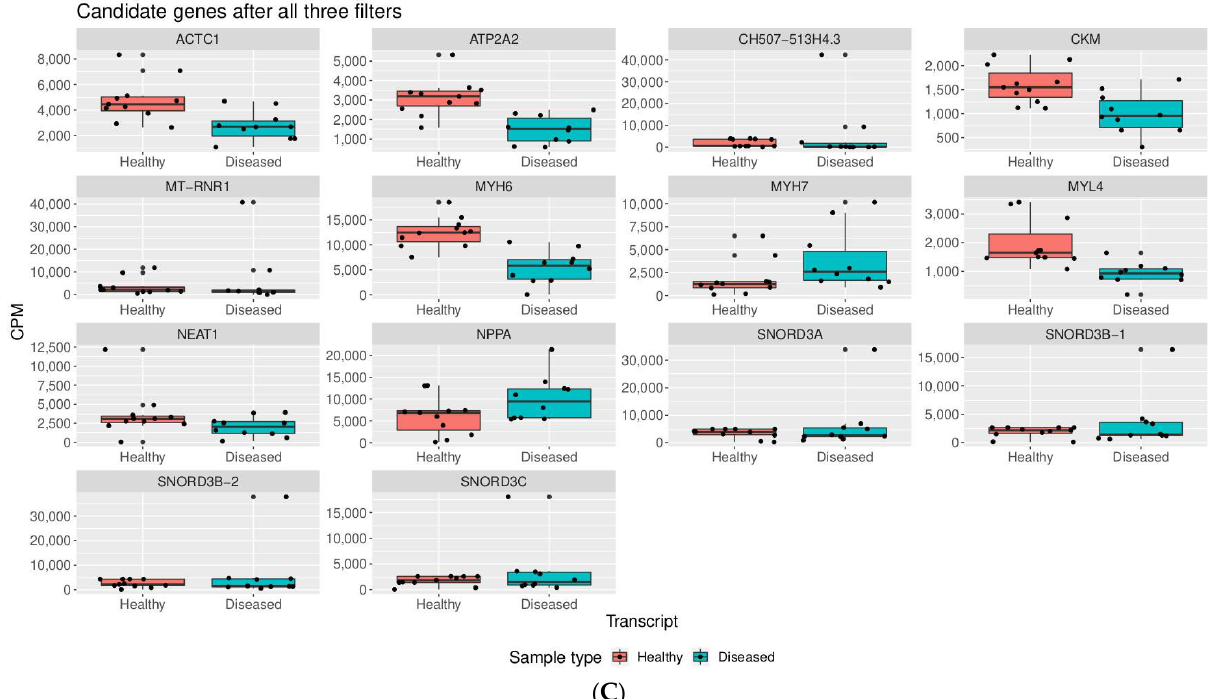
Figure 3. ( A ) Gene frequency of appearance after first selection. ( B ) Barplot reporting the number of retained genes after multiple feature selection step for every run of training/test. ( C ) DCM-related panel genes identified during feature selection step.